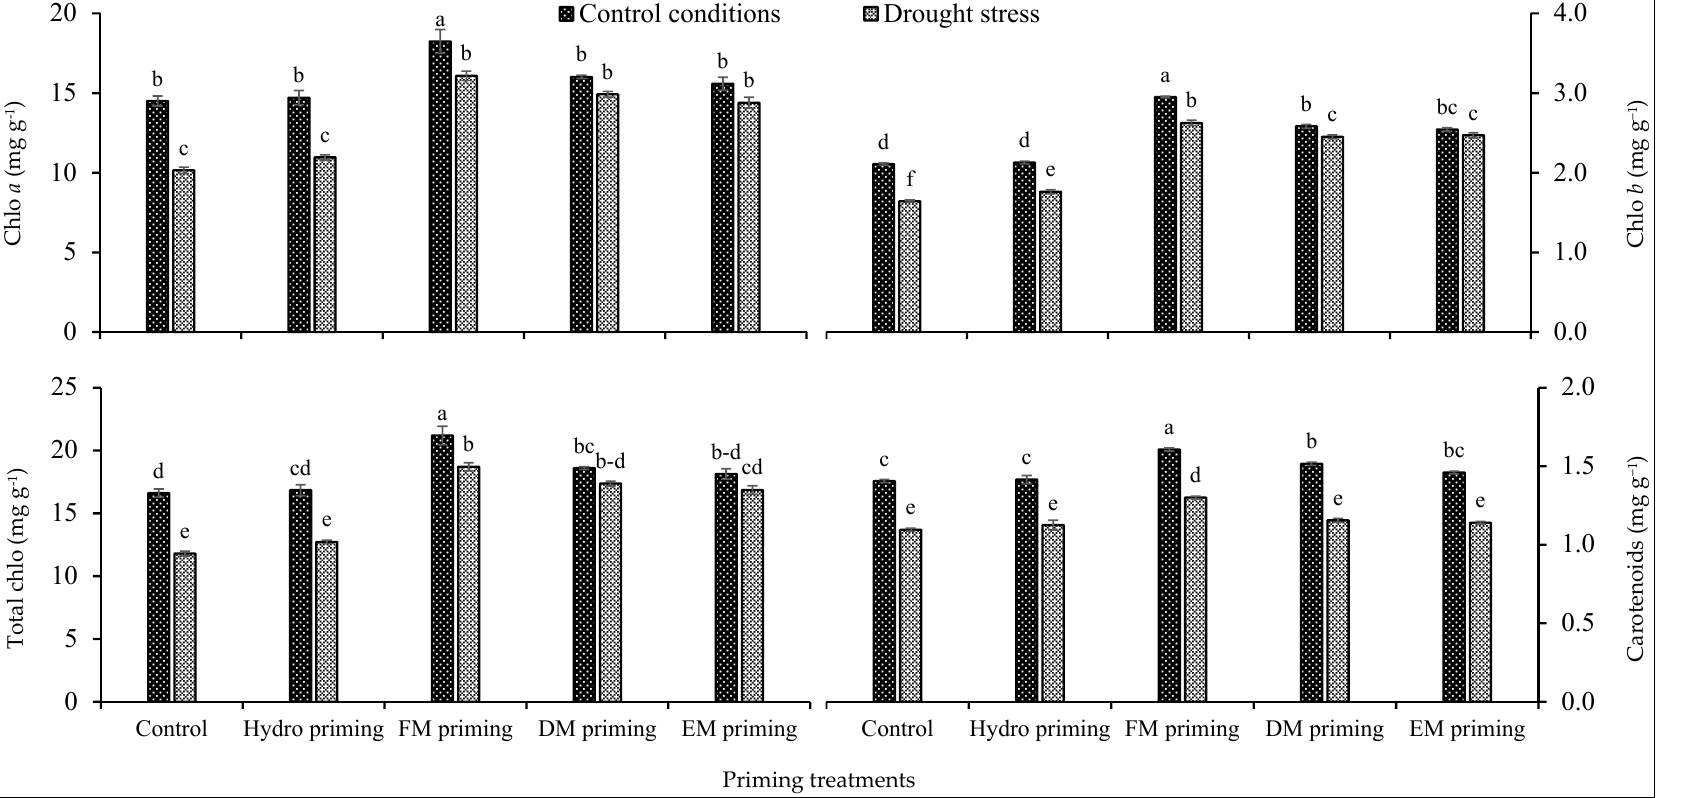
Figure 1. Impact of moringa leaf extracts as priming agents on photosynthetic pigments of rice seedlings cultivated under control and water deficit regimes. Bars sharing the same letter did not differ significantly at p = 0.05.